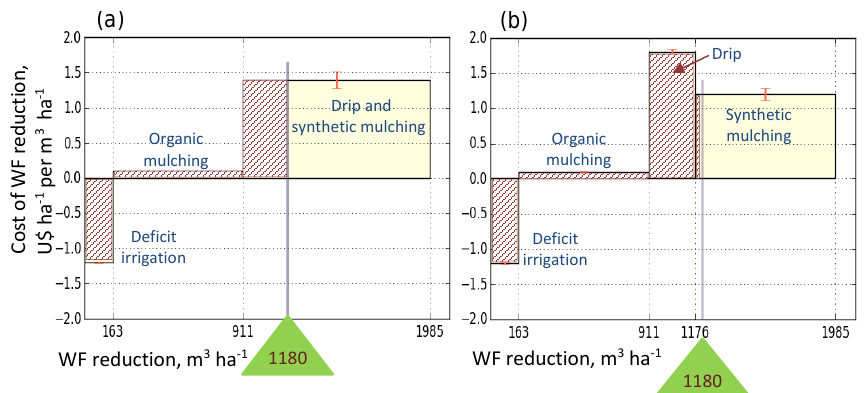
Figure 9. Application of the MCC in an example where the WF of maize production needs to be reduced. The baseline is sprinkler, full irrigation and no mulching with a WF of 6380m 3 ha − 1 . This needs to be reduced by 1180m 3 ha − 1 in order to meet a given local WF permit. (a) In the third step, drip irrigation combined with synthetic mulching is implemented on 25% of the area. (b) In the third step, drip irrigation (maintaining organic mulching) is implemented on 100% of the area, while in a fourth step synthetic mulching is implemented on 0.5% of the